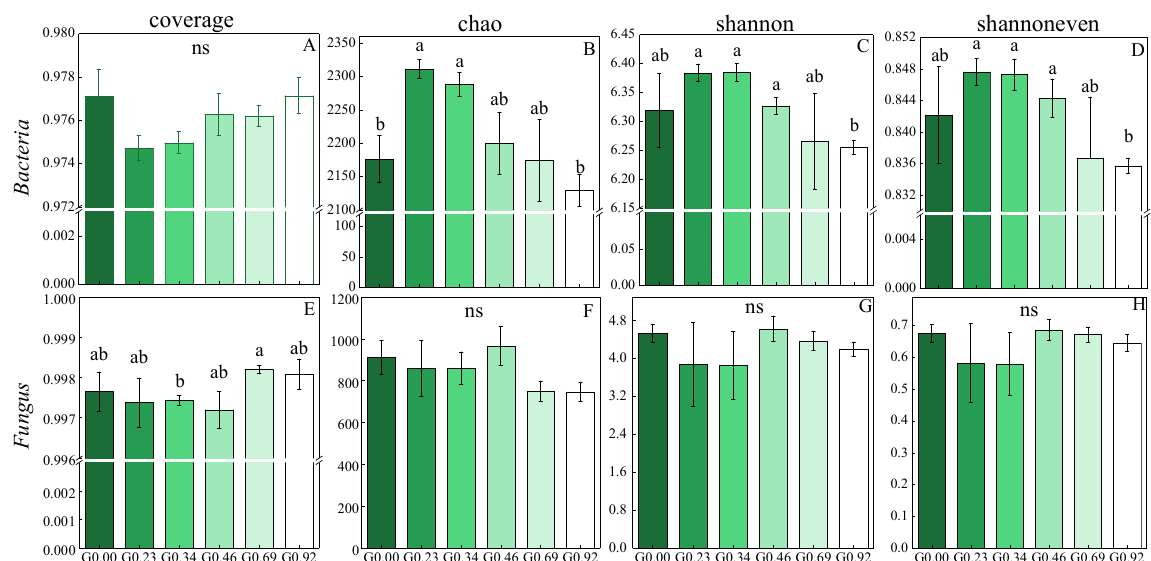
Figure 3. Estimated diversity indexes of bacterial and fungal communities. The Chao index reflects the richness of the community. The Shannon index reflects the diversity of the community and is used to estimate one of the indexes of microbial diversity in the sample; it also reflects the homo- geneity of the community. Significant differences are indicated by different letters.